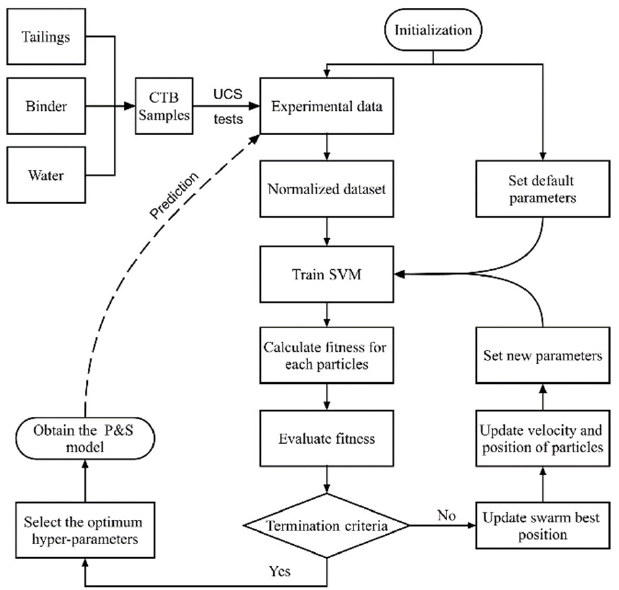
Figure 3. Flowchart of the P&S model for the UCS prediction.